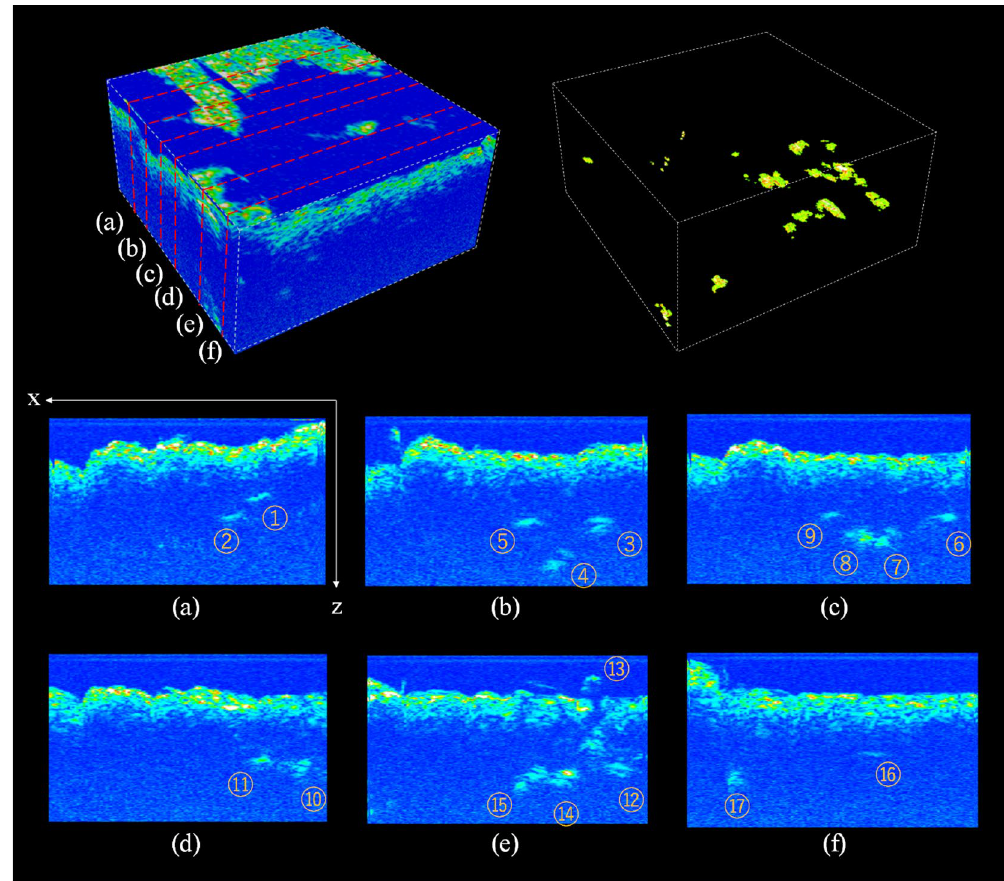
Figure 5. The cross-sectional views of the in situ imaging at x–z plane. ( a ) y = 50 mm, ( b ) y = 104 mm, ( c ) y = 134 mm, ( d ) y = 168 mm, ( e ) y = 204 mm, ( f ) y = 240 mm. The locations of the images are indicated in the top-left 3D acoustic image. Top-right image is a 3D rendering showing the locations of strong reflections below the surface with a certain threshold. The numbers (ID) are consistent with the ones in Supplemental Table